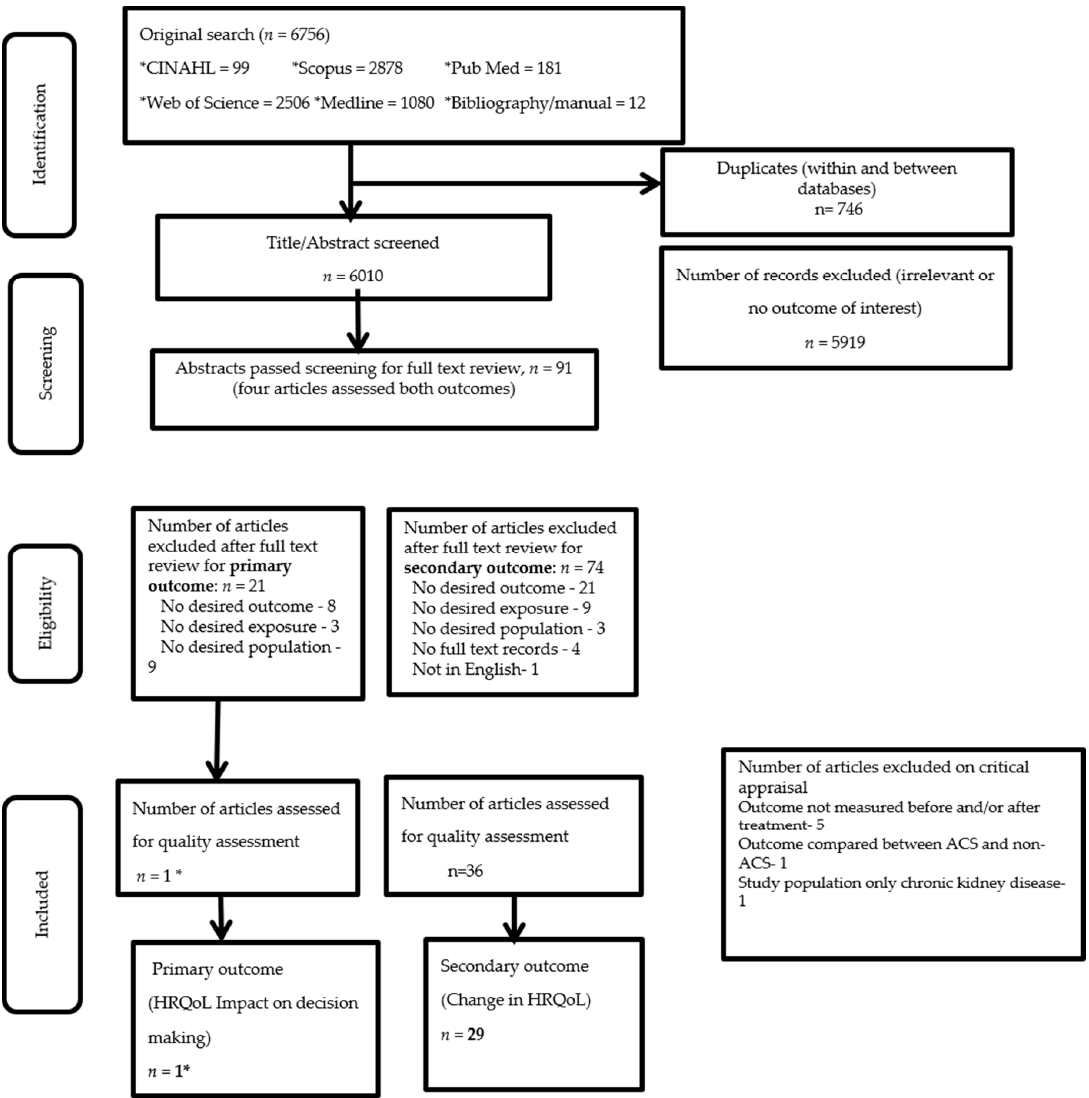
Figure 1. Preferred reporting items for systematic reviews and meta-analyses (PRISMA) flowchart for identification and selection of studies for inclusion in the systematic search, 2019. * One article assessed both outcomes.